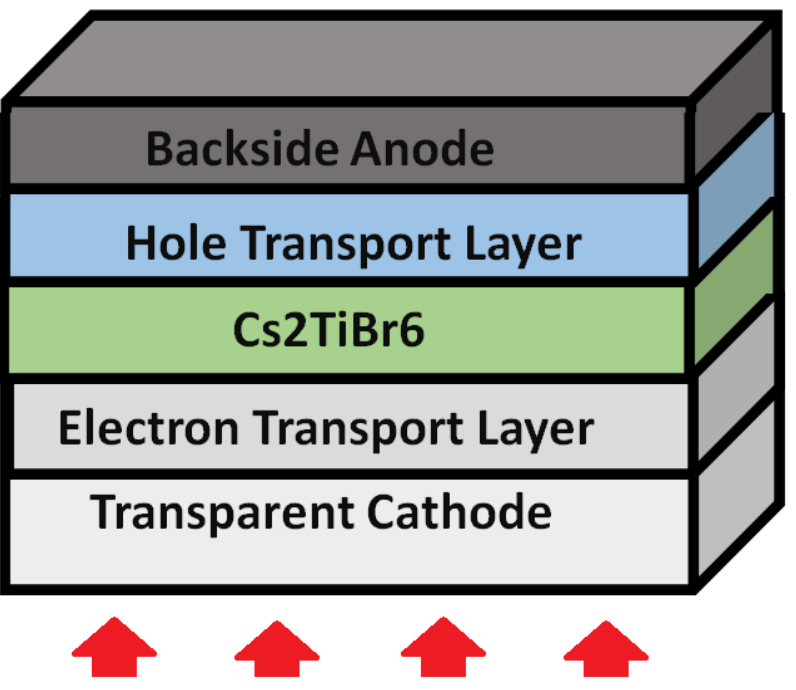
Figure 1. Schematic cross-section of perovskite solar cell, where absorber (Cs 2 TiBr 6 ) is sandwiched between hole transport layer (HTL) and an electron transport layer (ETL).